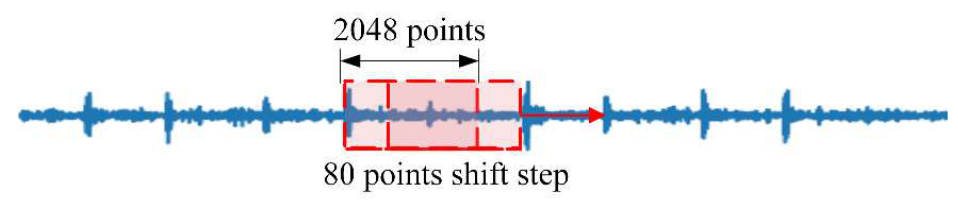
Figure 6. Generate sample with overlap.